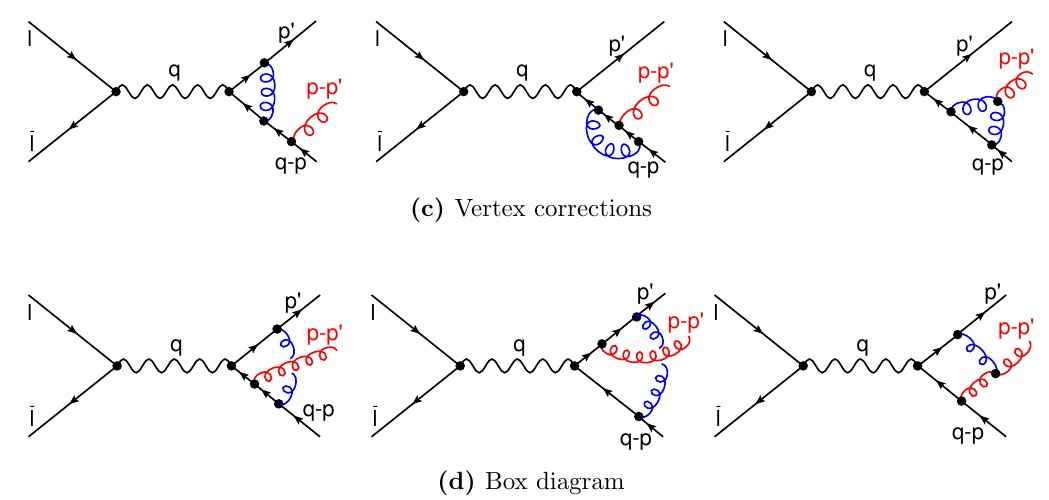
Figure 7. Virtual one-loop